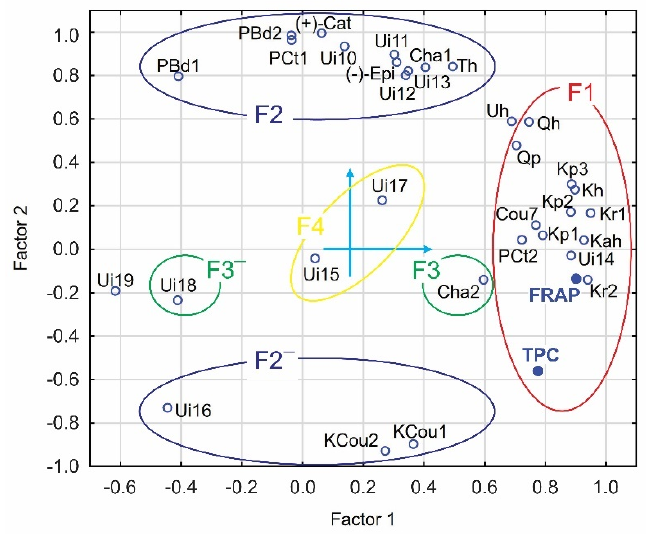
Figure 3. Results of the factor analysis for eastern hemlock sample; factor loadings Factor 1 vs. Factor 2. Rotation: Varimax normalized; Extraction: principal components. F1 denotes the group of vectors corresponding to Factor 1, and we use F2, F3 and F4 similarly. Please refer to the last column of Table 6. For the interpretation of the tags, please refer to Table 1. Table 6. Factor analysis of the polyphenol peak areas and the antioxidant properties of eastern hem- lock cone extracts. “Factor” indicates the factor that correlates best with the given concentration of a given compound; “Dist.” is the Euclidian distance of a given compound from the FRAP or the TPC vector. FRAP: Ferric Reducing Antioxidant Power; TPC: Total Polyphenol Content. For the inter- pretation of the tags, please refer to Table 1.